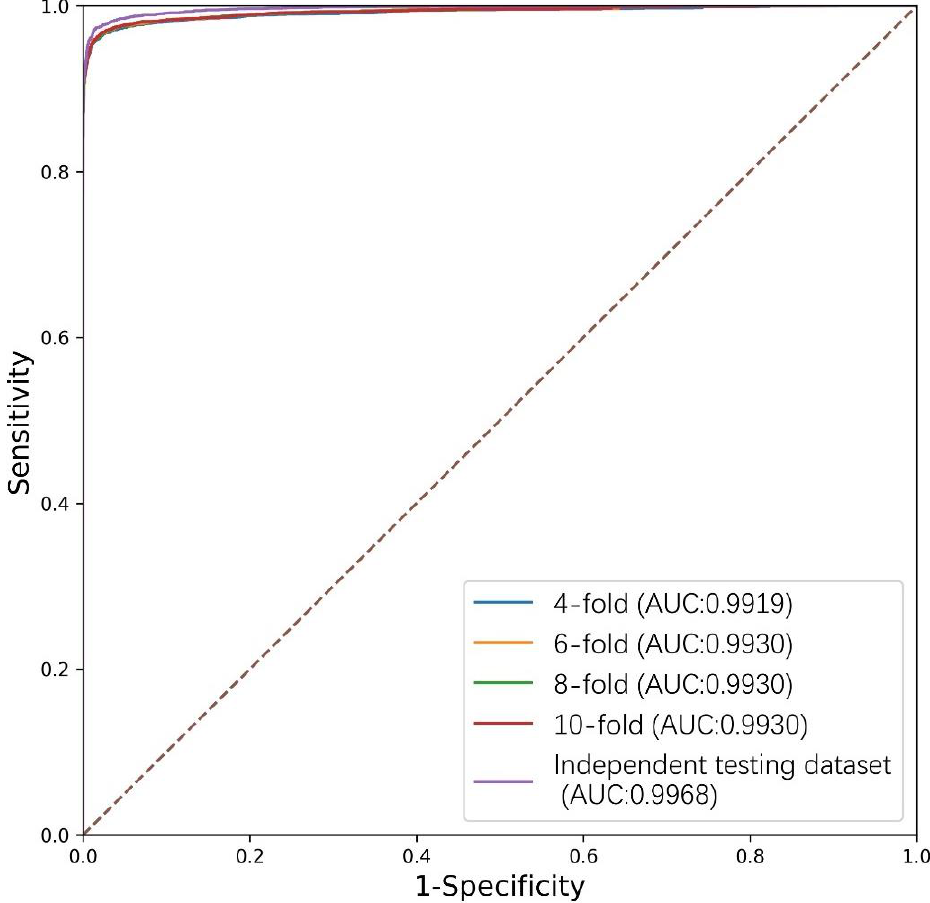
Figure 3. ROC (Receiver Operating Characteristic) curves and corresponding AUC (Area Under Curve) values of the 4-, 6-, 8- and 10-fold CVs (Cross-Validations) based on the training dataset and the independent testing dataset.